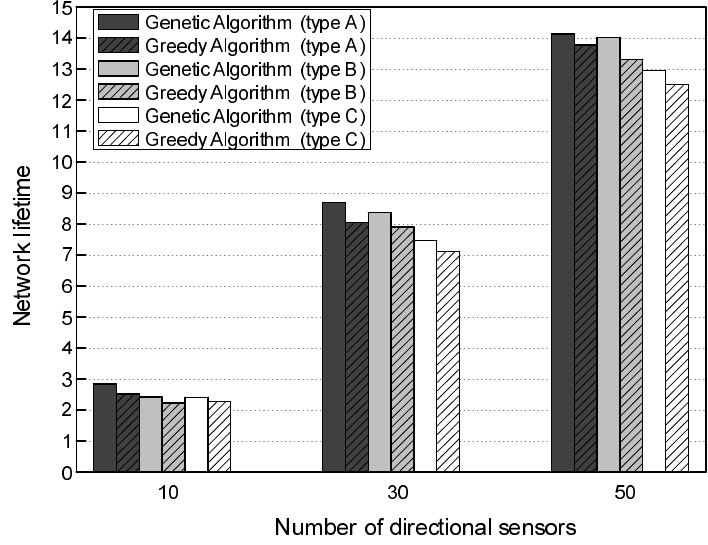
Comparison of network lifetimes for distribution of directional sensors with different sensing